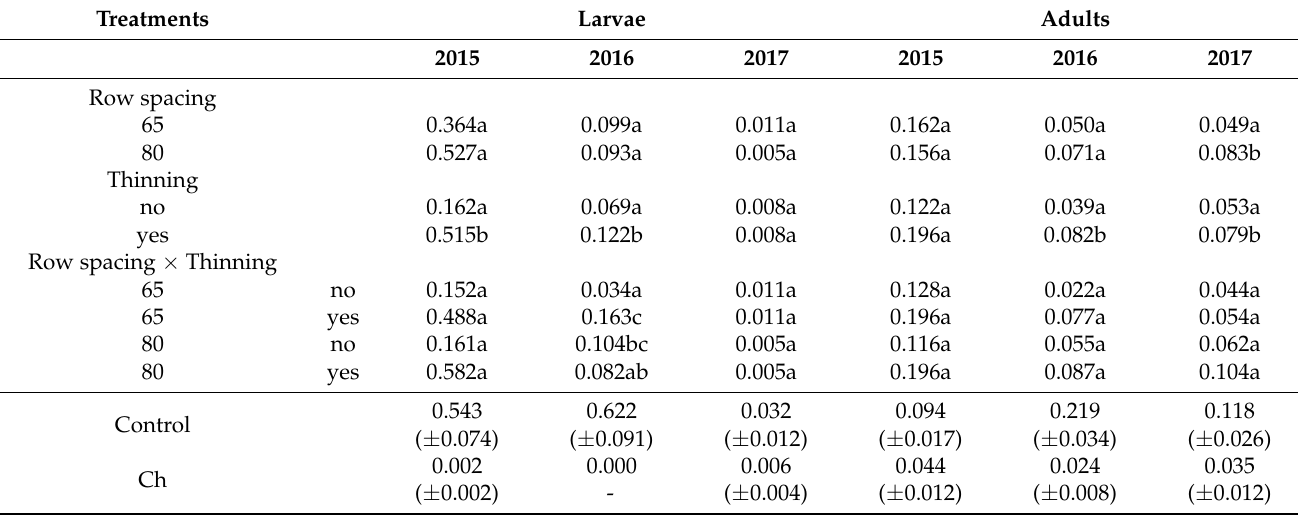
lower than in all other treatments. Comparing with control treatment number of hoverfly eggs in mustard treatments was similar (2015 and 2017) or higher (2016). No significant impact of thinning and row spacing on the number of lady beetle egg clutches laid could be observed (Table S2). Table 3. Mean numbers of Coccinelidae larvae and adults per one broad beans plant in the 2015–2017 seasons. Treatments